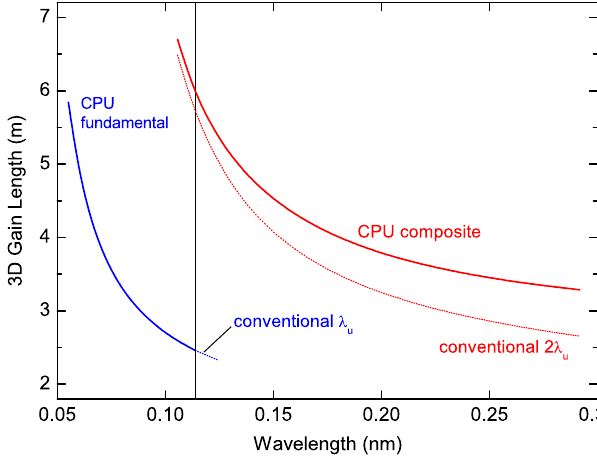
5. Calculation results of the field distribution generated by the CPU. The blue and red lines show the field distributions in the double-period and fundamental modes,